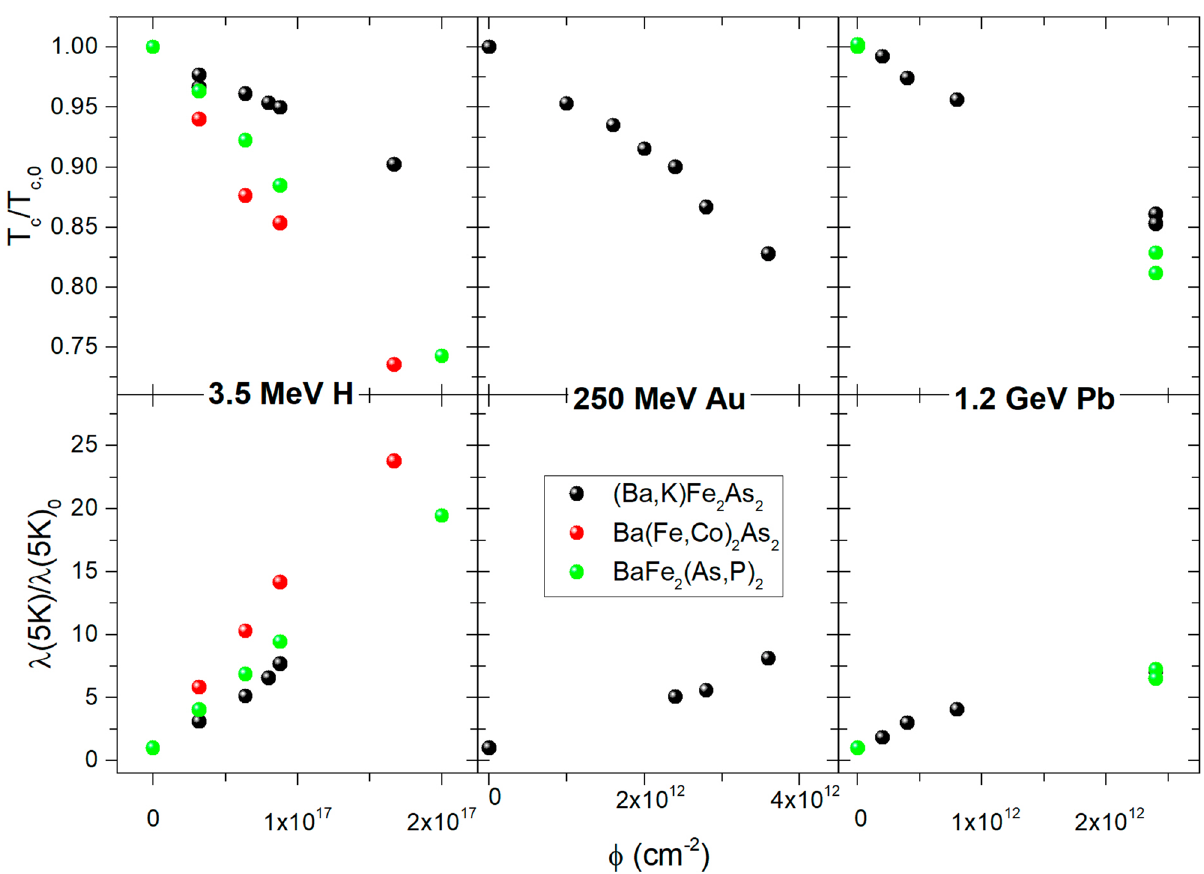
Figure 1. Critical temperature degradation (top panels) and low temperature London penetration depth increase (bottom panels) expressed as the ratio between the values for a certain fluence and for the pristine sample ( T c / T c ,0 and (cid:31) (5K)/ (cid:31) (5K) 0 ), as a function of irradiation fluence, for 3.5 MeV proton irradiation on the left, 250 MeV Au ion irradiation at the center, and 1.2 GeV Pb ion irradiation on the right. Absolute values for the pristine samples are reported in the Methods